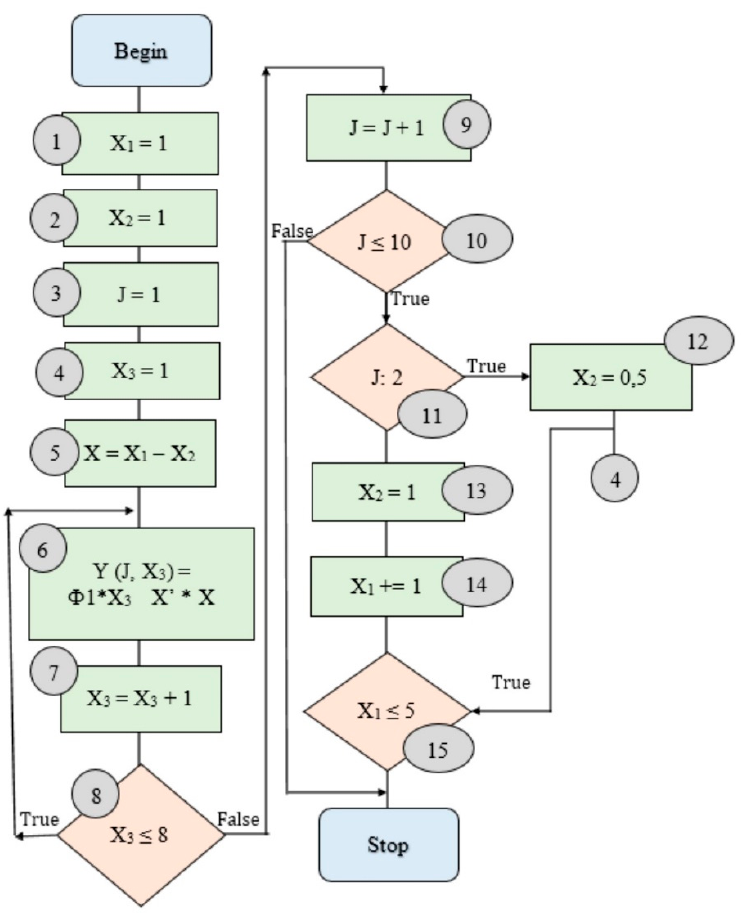
Figure 5. A block scheme of selecting the belt grinding speed: Y is the speed of the grinding belt v c , m/s; Y = f ( X 1 , X 2 , X 3 ); X 1 i are material machinability groups ( k m ); X 2 is the type of machining (allowance up to 1 mm or 0.05 mm); X 3i is the belt strength groups ( σ p ).